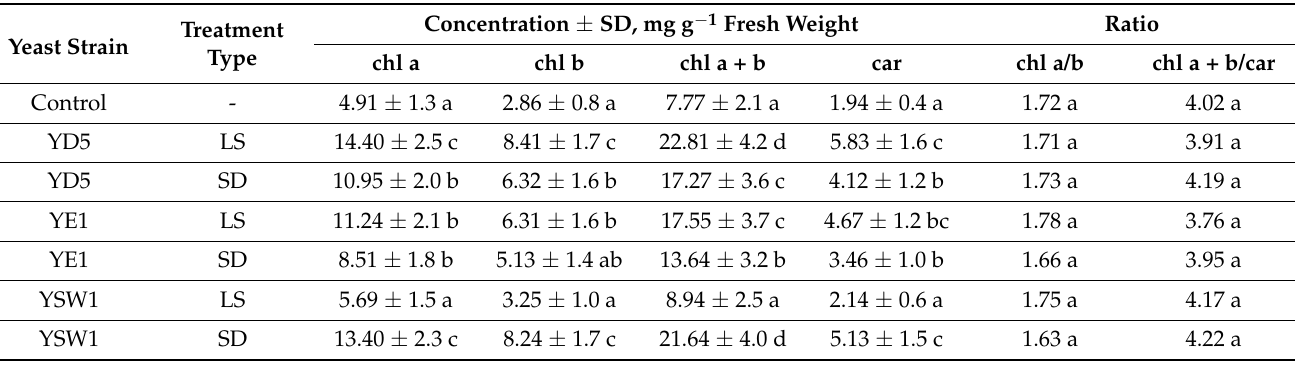
Table 5. Assay for photosynthetic pigments in experimental plants treated by soil drench (SD) and leaf spraying (LS) 14 day after the first treatment.